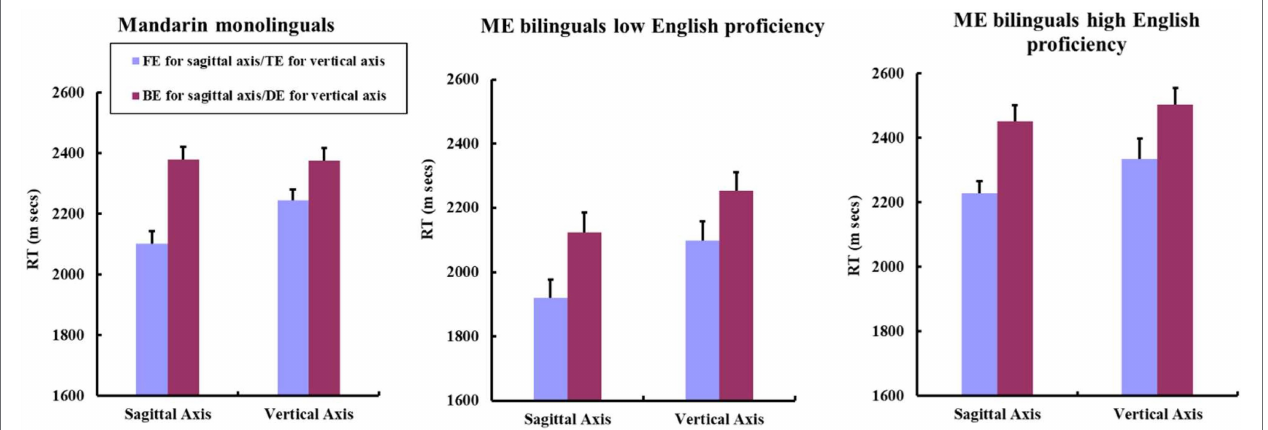
FIGURE 4 | Mean RTs for FE and BE mouse mappings along the sagittal axis; TE and DE mouse mappings along the vertical axis by Mandarin monolinguals, ME bilinguals with low English proficiency and ME bilinguals with high English proficiency. The figure plotted by participants’ mean RTs. Error bars indicate standard errors of the